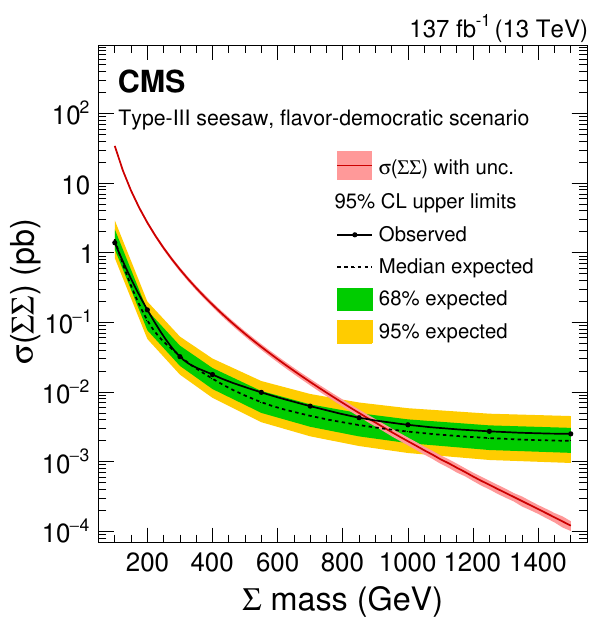
Figure 11 . The 95% con(cid:12)dence level expected and observed upper limits on the total production cross section of heavy fermion pairs. The inner (green) and the outer (yellow) bands indicate the regions containing 68 and 95%, respectively, of the distribution of limits expected under the background-only hypothesis. Also shown are the theoretical prediction for the cross section and the associated uncertainty of the (cid:6) pair production via the type-III seesaw mechanism. Type-III seesaw heavy fermions are excluded for masses below 880 GeV (expected limit 930 GeV) in the (cid:13)avor-democratic